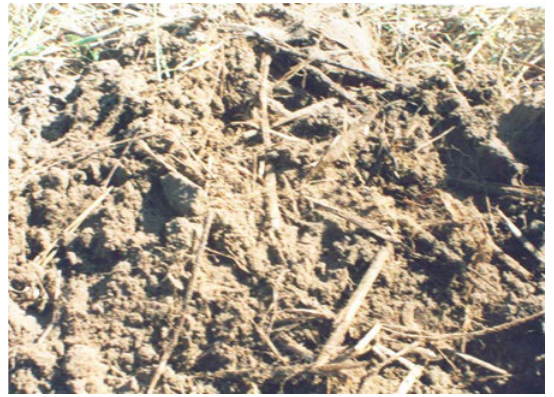
Figure 5. Leftover undecomposed straw at the end of the experiment.